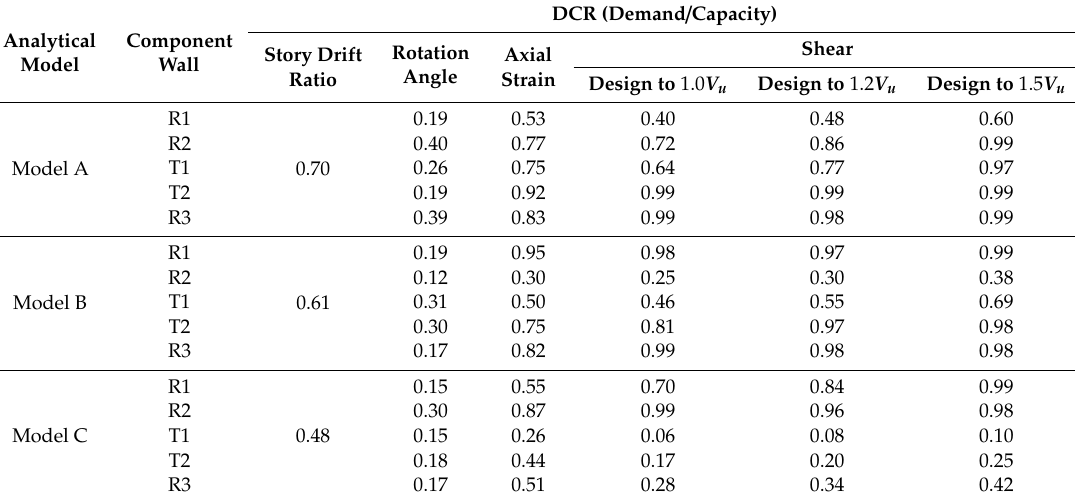
Figure 6. Example of design result for R3 in Model A. Table 7. Design results for average response of seven ground motions.